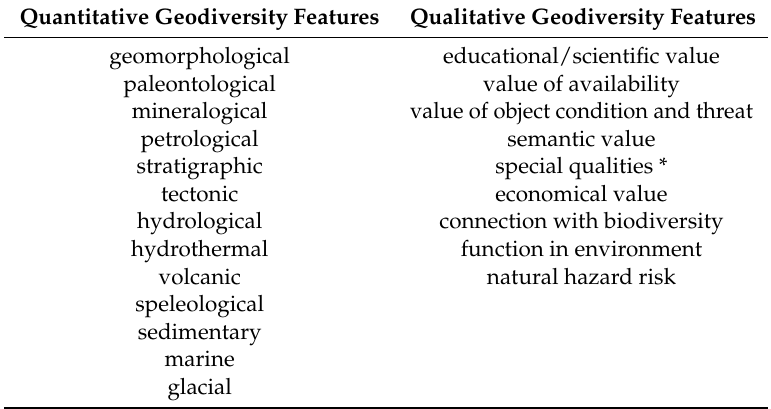
Table 1. Most used features of quantitative and qualitative